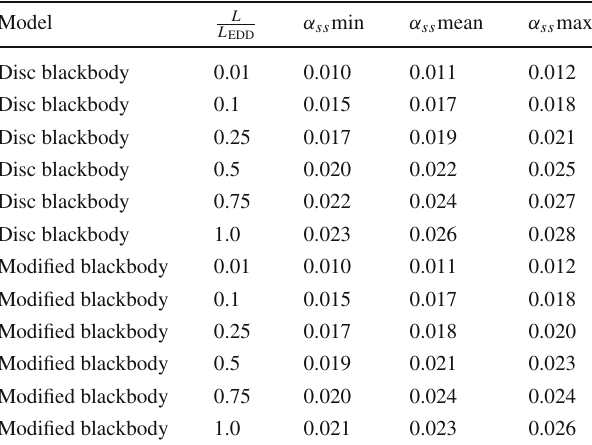
Table 1 Model parameter for the Palomar–Green data, with corre- sponding mass and accretion rate range of 10 7 < M < 10 8 . 5 M (cid:5)